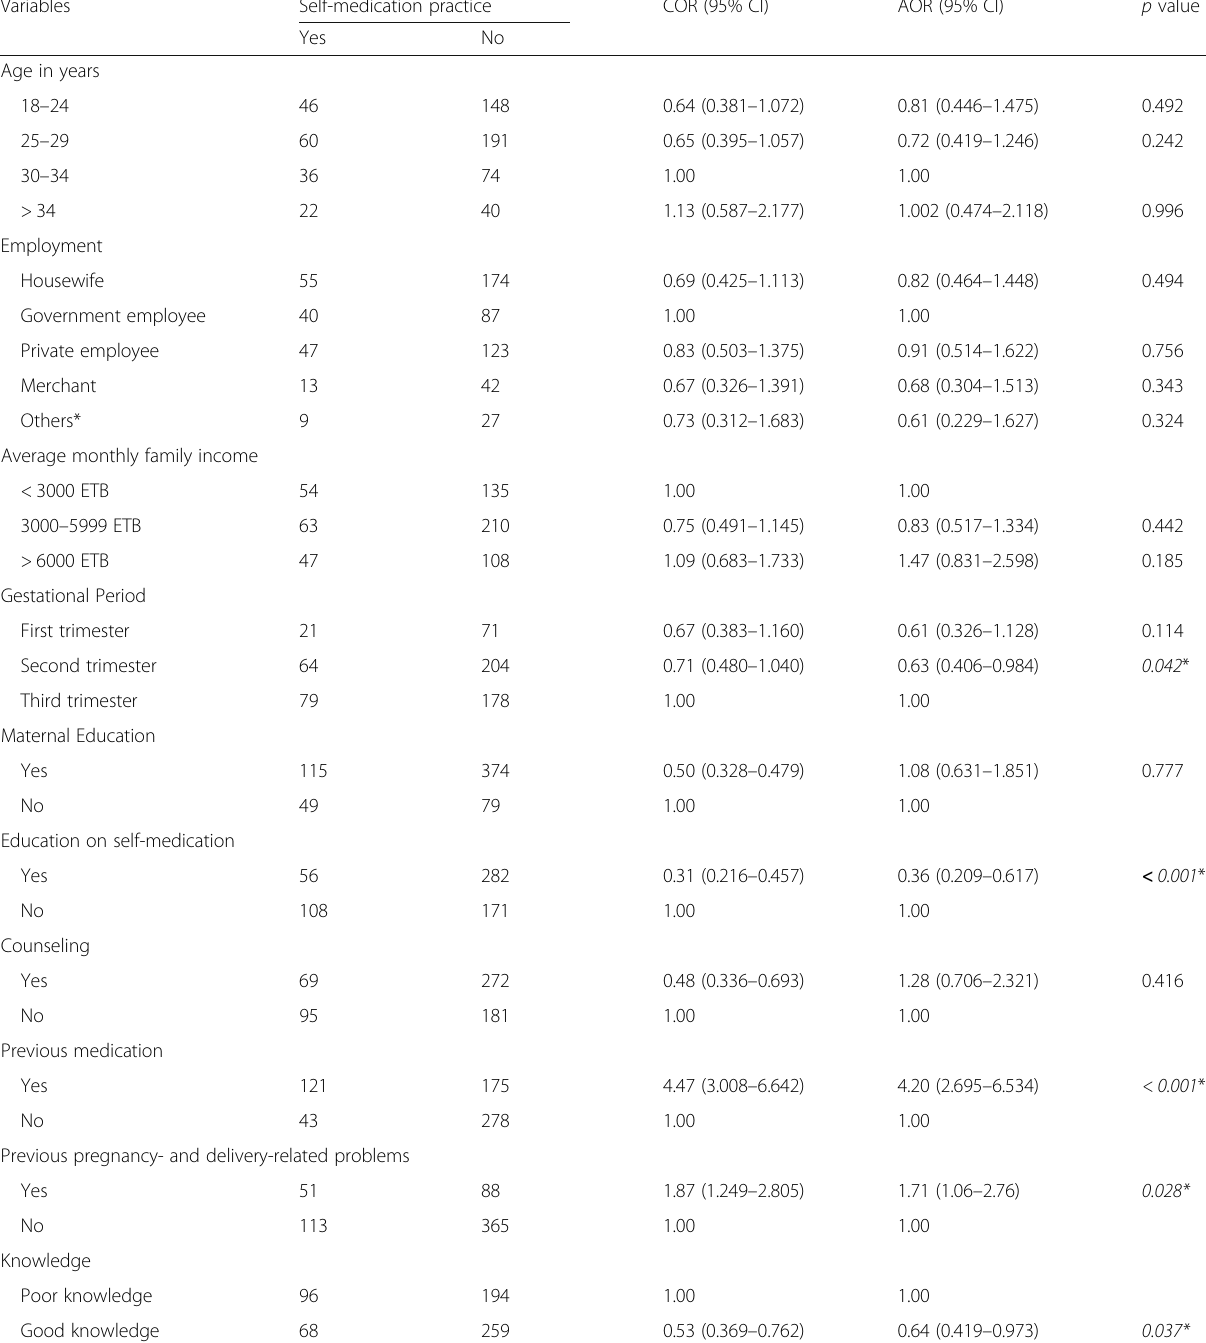
Table 7 Univariate and multivariable analysis of factors associated with self-medication practice among pregnant women in Addis Ababa, 2017 ( n = 617)